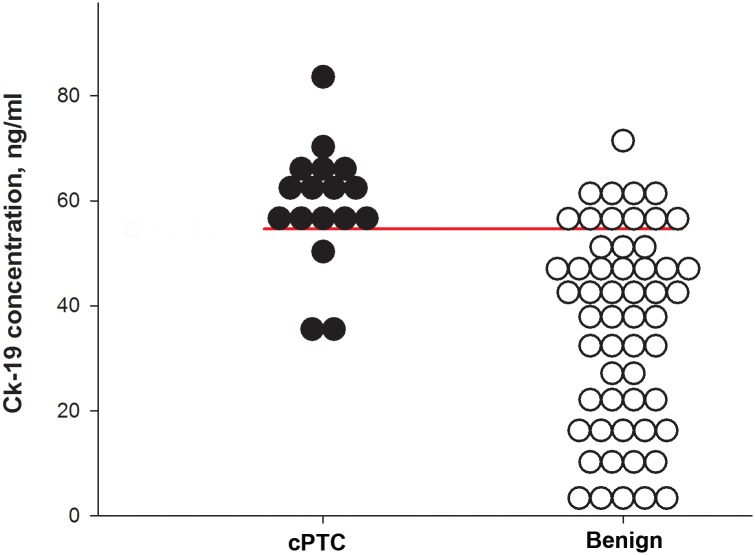
Scatter plots illustrating the distribution of CK-19 concentrations in fluid from cPTC and benign controls.The horizontal bar indicates the optimal cut-off for discrimination between cPTC and benign thyroid cyst samples.